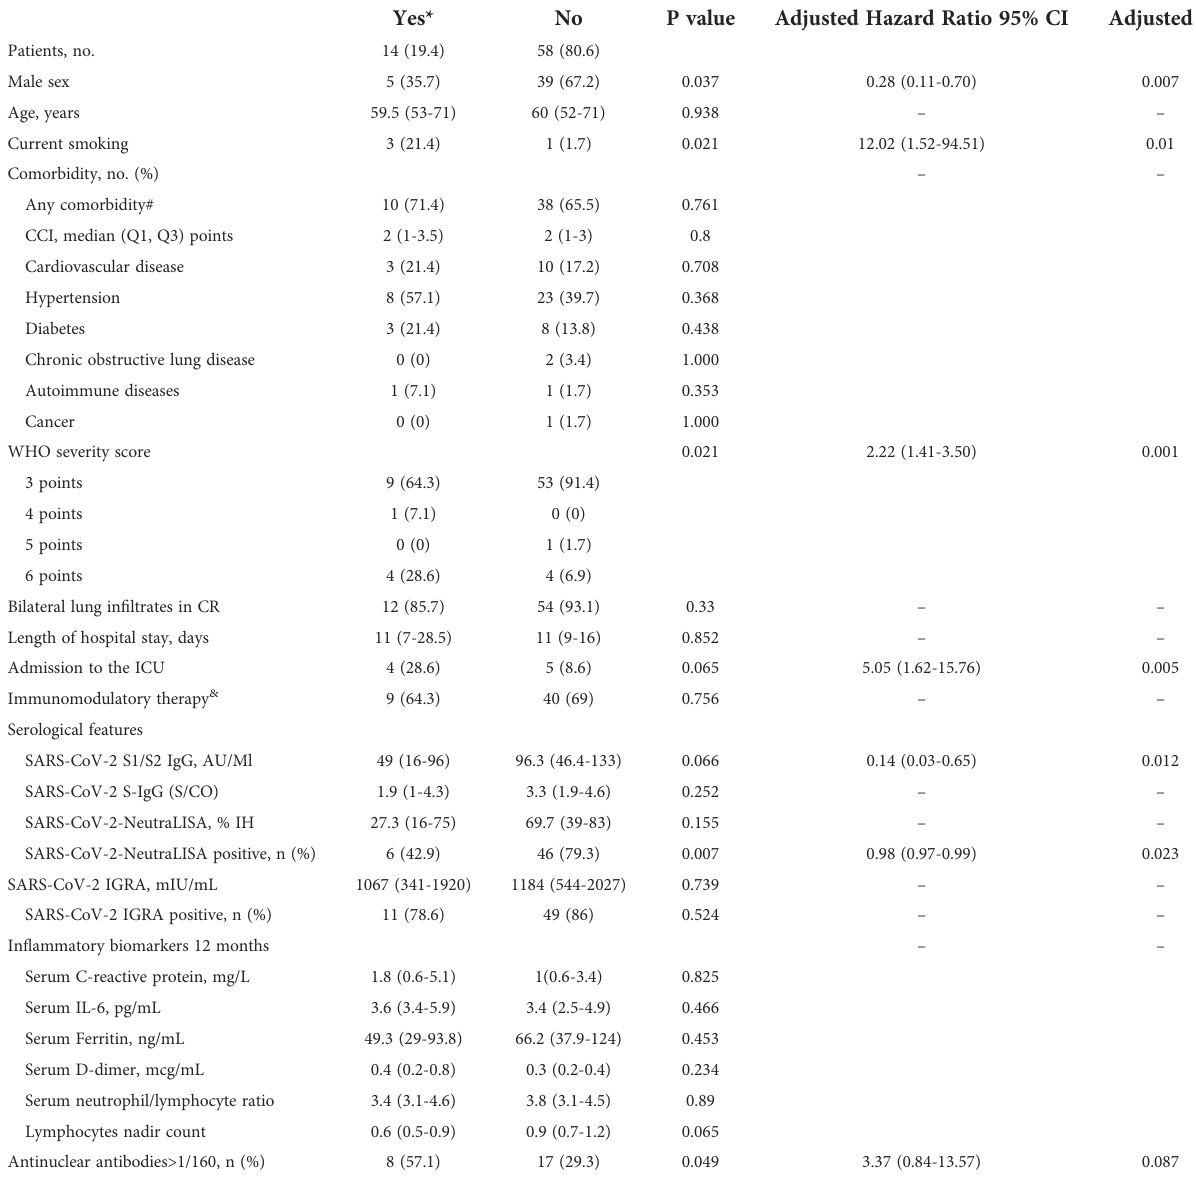
TABLE 1 Clinical, serological and biomarker data according to the persistence of symptoms at 6 and 12 months after hospital admission for COVID-19. Persistent symptoms at 6 and 12 months Yes* No P value Adjusted Hazard Ratio 95% CI Adjusted P Patients,